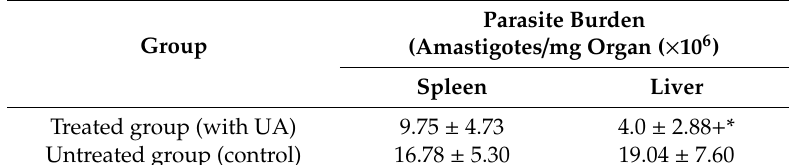
Table 4. In vivo anti-leishmanial e ffi cacy of UA against L. infantum in chronic infection model of VL in Syrian golden hamsters. Parasite burden of the control (untreated) group and treated group with UA parenterally administered at 5 mg / kg daily for seven consecutive days is expressed as mean parasite number ± standard deviation in spleen and liver per